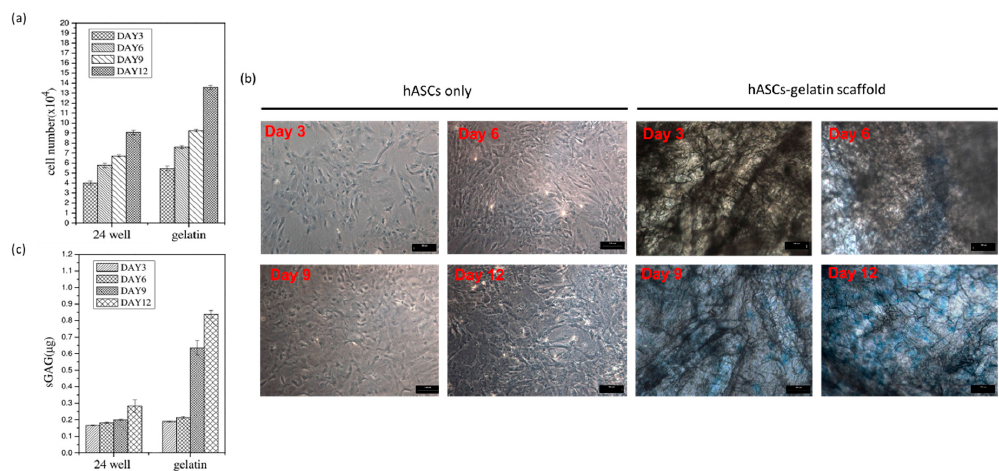
Figure 6. Evaluation of chondrogenesis of human adipose stem cells (hASCs) cultured on the gelatin scaffold. ( a ) Proliferation of hASCs; ( b ) Alcian Blue staining of the proteoglycan aggrecan, a chondrogenesis indicator, revealing dark-blue puncta (scale bar = 100 µm); ( c ) Dimethylmethylene (DMMB) Blue assay.